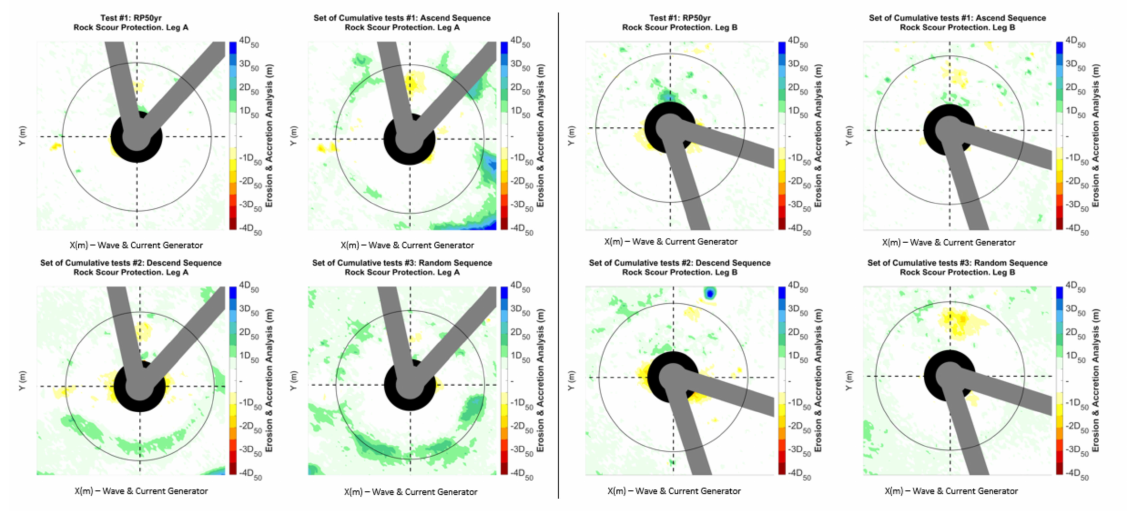
Figure 14. Left : leg A. Right : leg